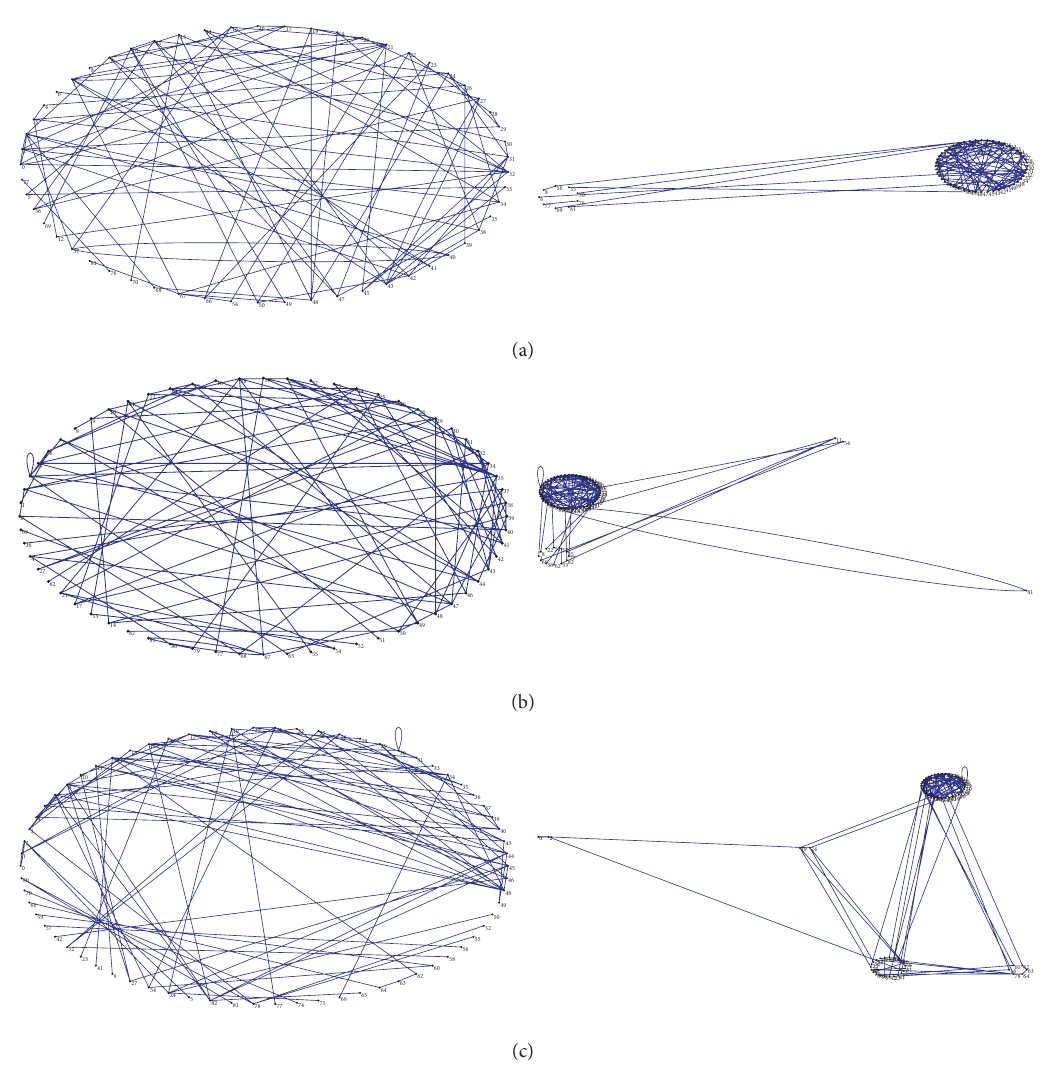
Figure 4: Left column is the exact result of partition of crime networks at Δ𝑡 , 2 ∗ Δ𝑡 , and 3 ∗ Δ𝑡 ; right column shows the visualization results of partition in 3D space. The nodes with the same color mean that they belong to the same partition.